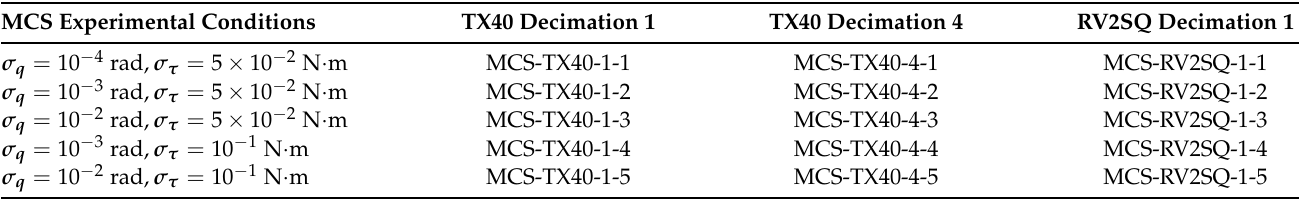
Table 1. Overview and naming convention of the different experiments performed during the MCS. The first row of the table refers to noise conditions that are close to what can be encountered on an industrial robot manipulator. The four other rows explore the performance of identification in the case of substantially higher joint position and torque noise